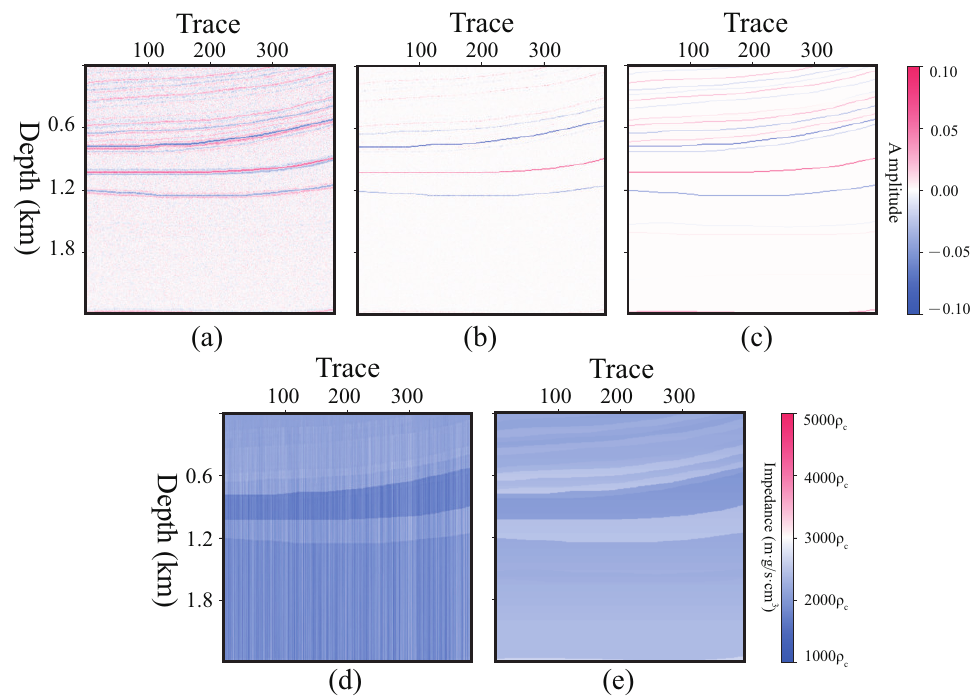
Figure 21. Profiles of deconvolution and recursive inversion. ( a ) Seismic profile M , ( b ) ˆR profile by deconvolution, ( c ) R profile, ( d ) ˆZ profile by recursive inversion, ( e ) Z profile.